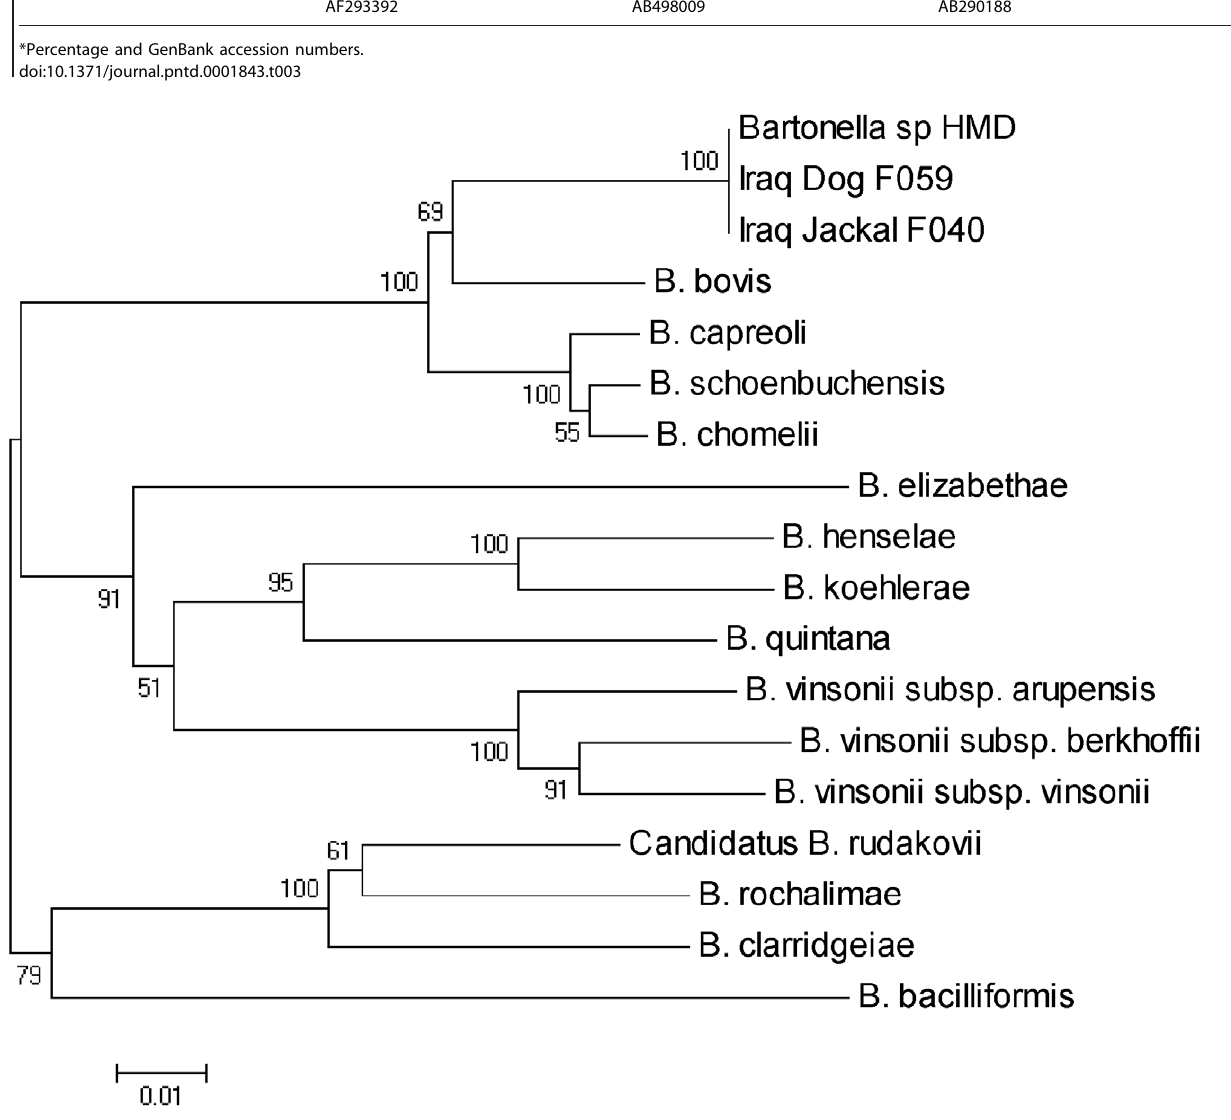
Bartonella species